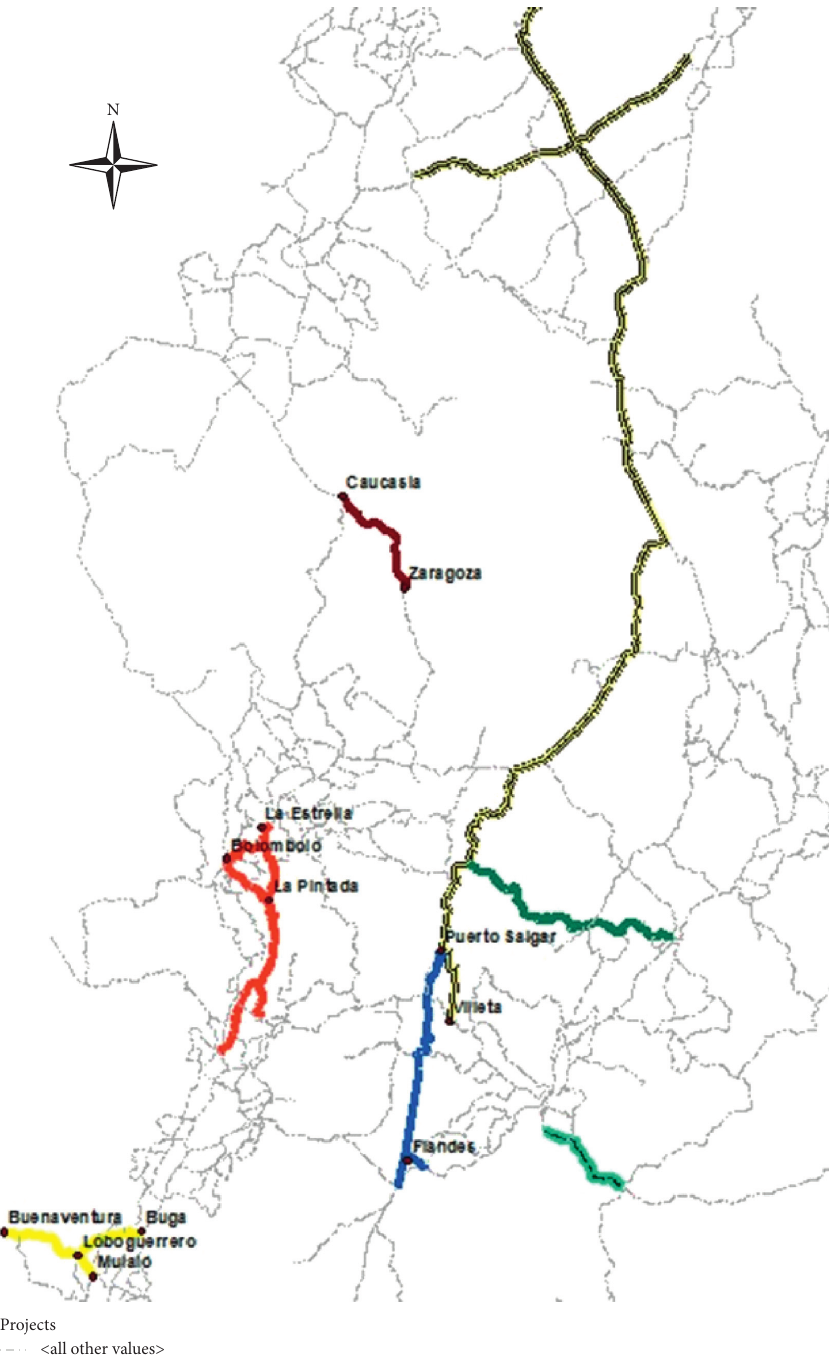
Figure 3: Road infrastructure projects